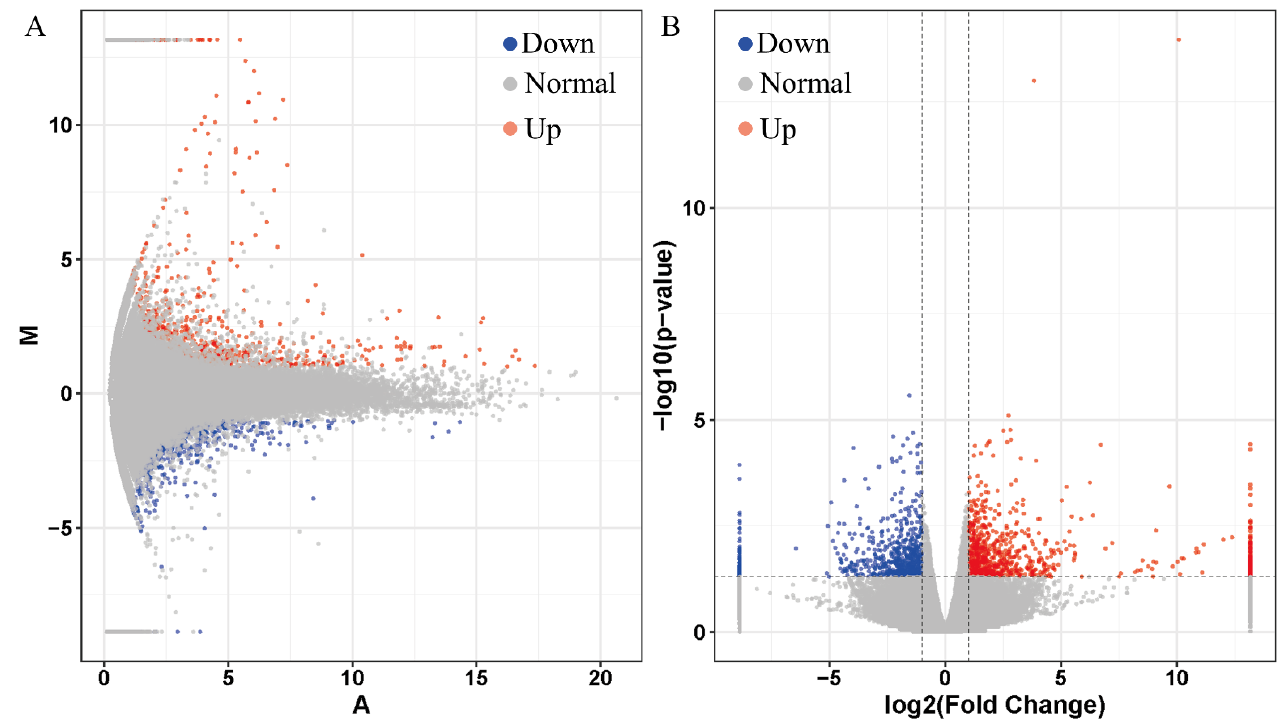
Figure 1. Differentially expressed genes (DEGs) identified in Rana nigromaculata exposed to PFOS in comparison to the control. Differentially expressed genes between the control and the nanoplastic- treated group were visualized as an MA (M-versus-A) plot ( A ) and volcano plot map ( B ). Blue and red dots indicate down-regulation and up-regulation of differentially expressed genes in the PFOS treated group in comparison to the control, respectively. (For interpretation of the references to color in this figure legend, the reader is referred to the web version of this article).